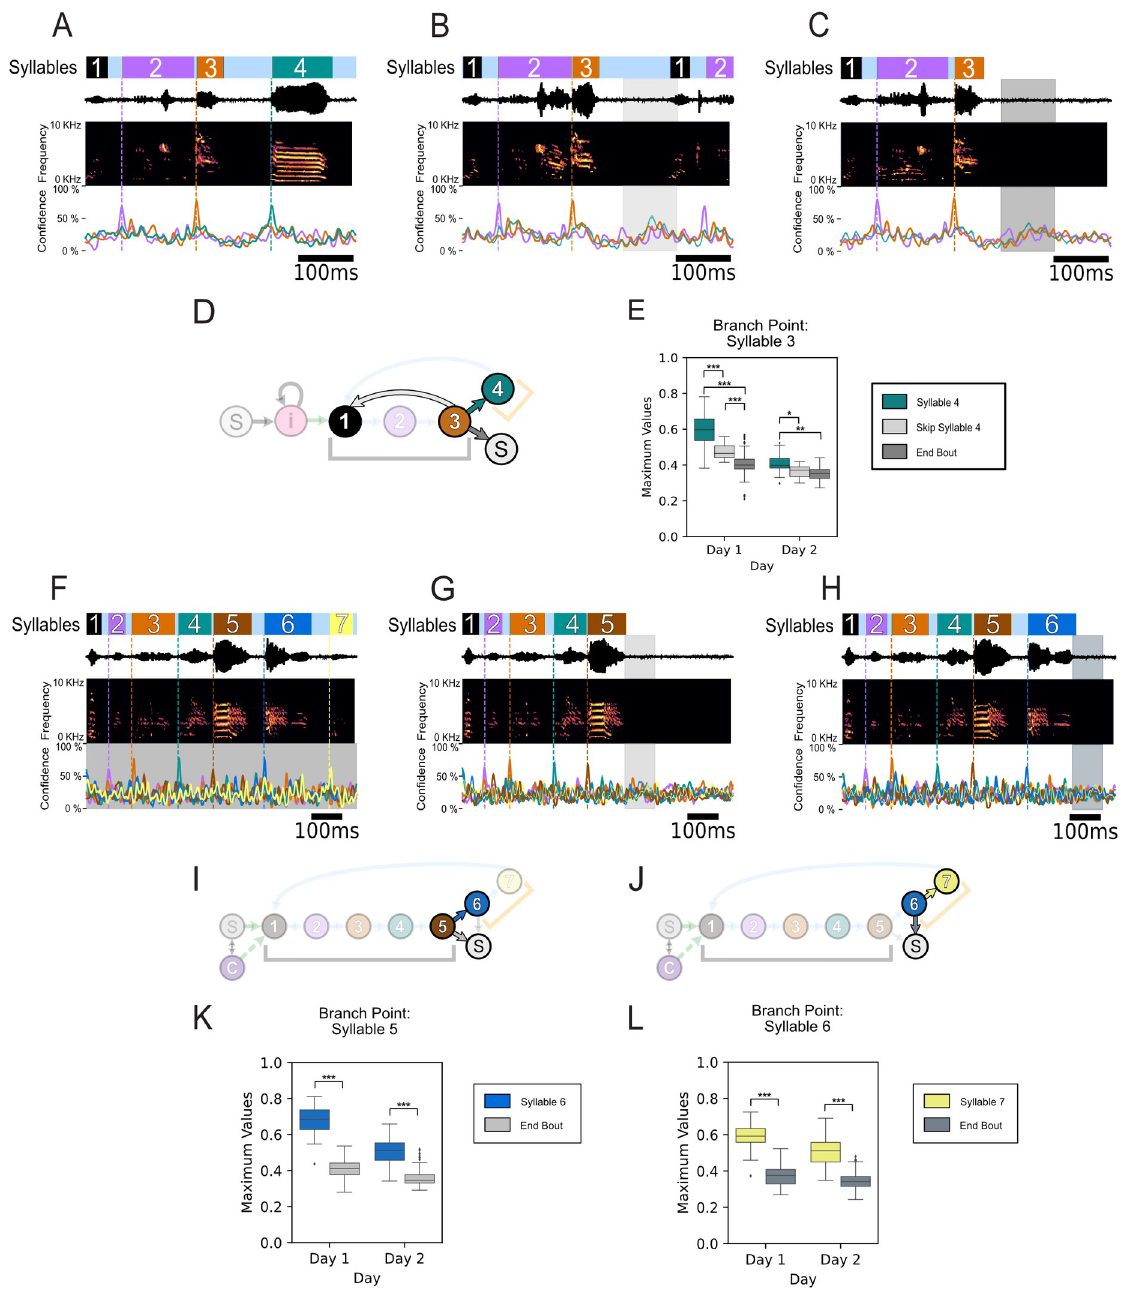
Fig 11. Onset prediction of non-deterministic syllables and decoding divergent behaviors using LFP features. (A) Example motif with all four syllables from the highest-yield day for subject z020. Annotated behavior (top) using the same color scheme as in Fig 3 , sound pressure waveform and the corresponding time-aligned spectrogram (middle), and the time-varying na ï ve confidence of the onset prediction (bottom) for each syllable in this example motif. (B) Example motif from the same high-yield day as (A) where the subject skips syllable 4 and continues the bout. The shaded lightgray time period is the time window that the behavior-based model would predict that the omitted syllable would occur. (C) Example motif from the same high-yield day as (A) where the subject ends the bout with syllable 3. The shaded darkgray time period is the time window that the behavior-based model would predict that the omitted syllable would occur. (D) State diagram of z020’s observed song structure with the three transition types highlighted; ‘Syllable 4’: syllable 3 to syllable 4 (teal) shown in (A); ‘Skip Syllable 4’: syllable 3 to syllable 1 (lightgray) shown in (B); ‘End Bout’: syllable 3 to silence (dark gray) shown in (C). Syllable colors are the same as in Fig 3 . (E) Boxplot of the difference in maximum confidence values between the three behavioral transition types shown in (A–C) using the same transition colors used in (D) across both high-yield days. (F) Example motif with all seven syllables from the highest yield day for subject z017. (G) Example motif from the same high yield day as (F) where the subject ends the bout with syllable 5. The shaded